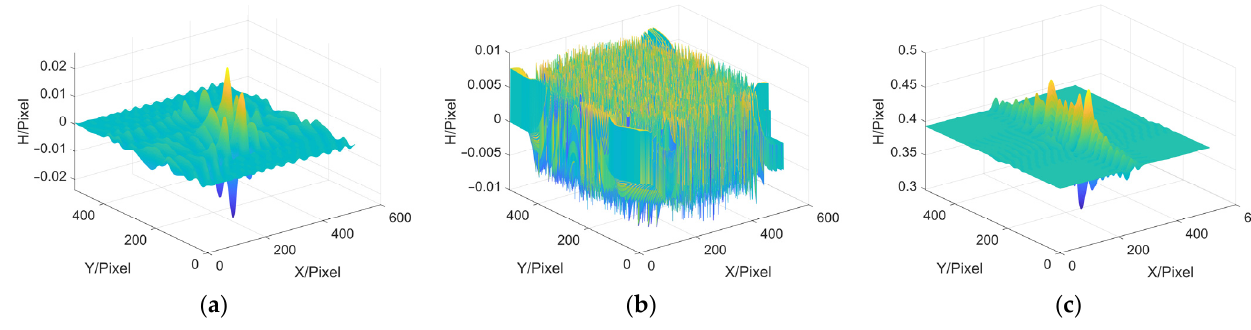
Figure 4. Error distributions. ( a ) MP; ( b ) PMP; ( c ) FTP.